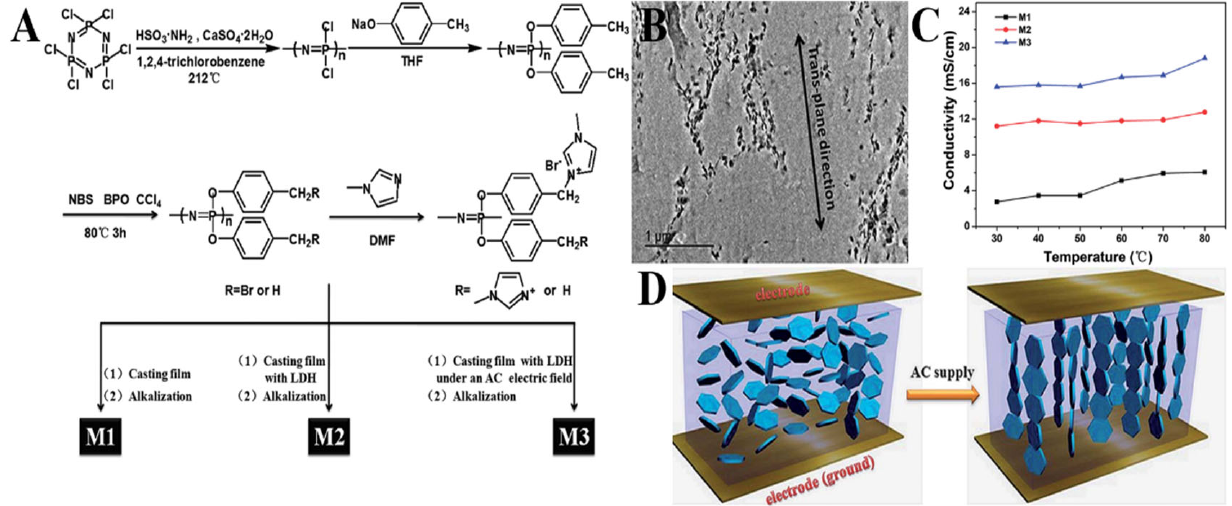
Figure 6. ( A ) The scheme of membrane fabrication. ( B ) TEM image of membrane with LDH under an AC electric field. ( C ) AEMs ionic conductivity as a temperature function. ( D ) The schematic diagram of electric field-introduced orientation of LDH nano-platelets in a heterogeneous solution. Taken with permission from [126].